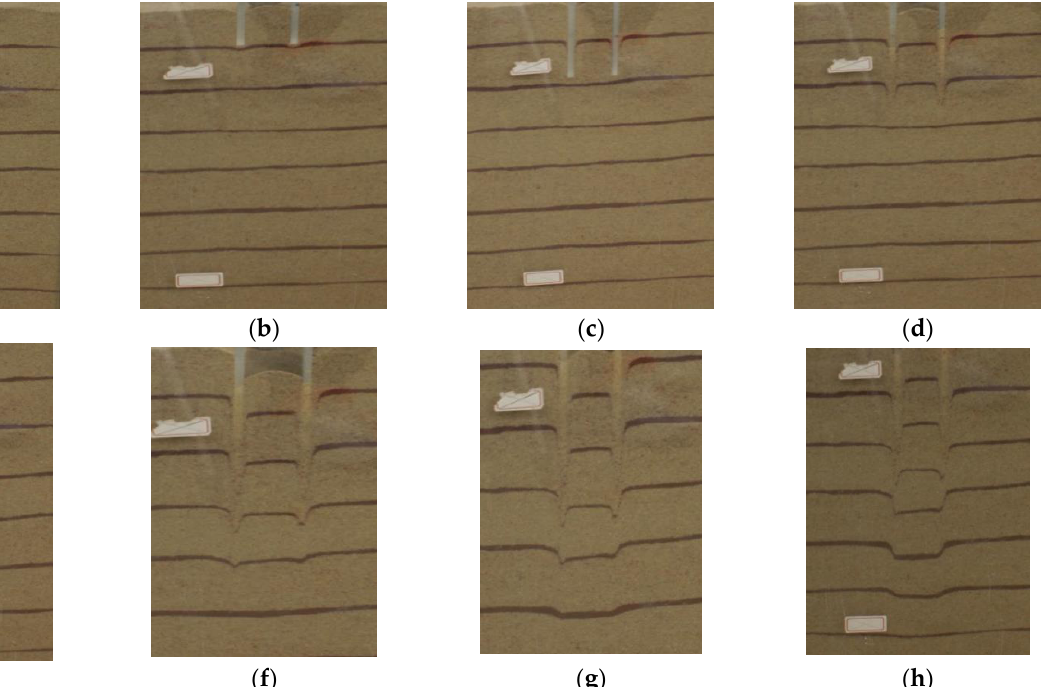
Figure 14. Soil plug phenomenon of pipe pile ( a ) before pressing piles, ( b ) at the pressed depth of 50 mm, ( c ) at the pressed depth of 100 mm, ( d ) at the pressed depth of 150 mm, ( e ) at the pressed depth of 200 mm, ( f ) at the pressed depth of 250 mm, ( g ) at the pressed depth of 300 mm, and ( h ) at the pressed depth of 350 mm.